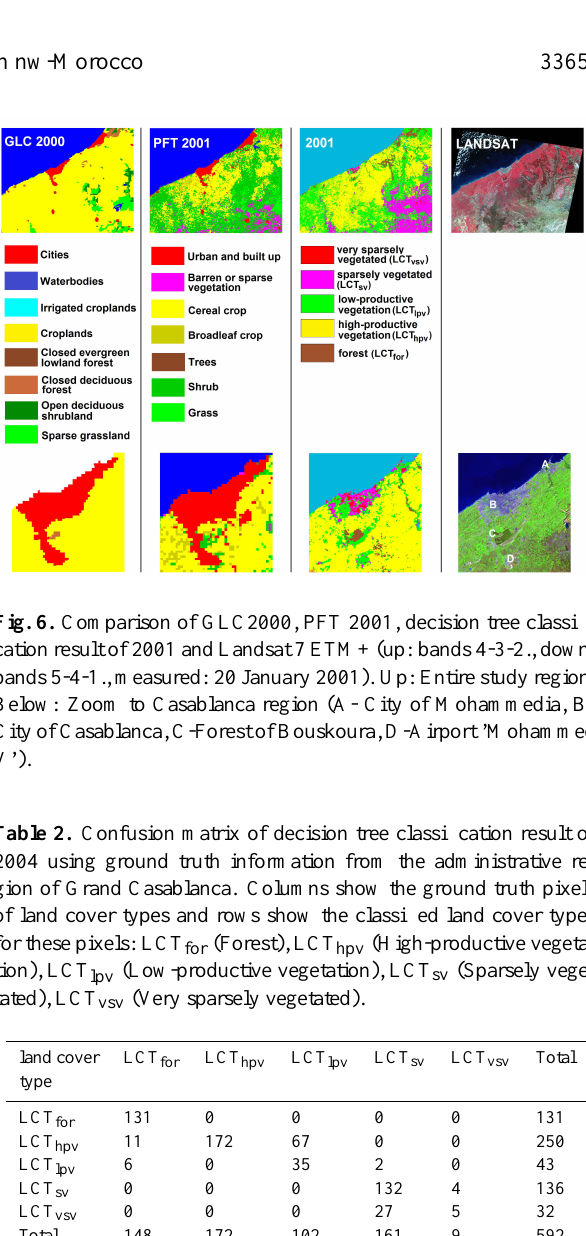
Fig. 5. Annual land cover classification results of 2002 to 2009.